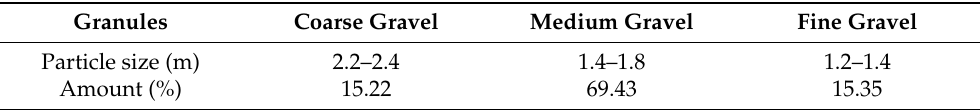
Table 1. Particle gradation